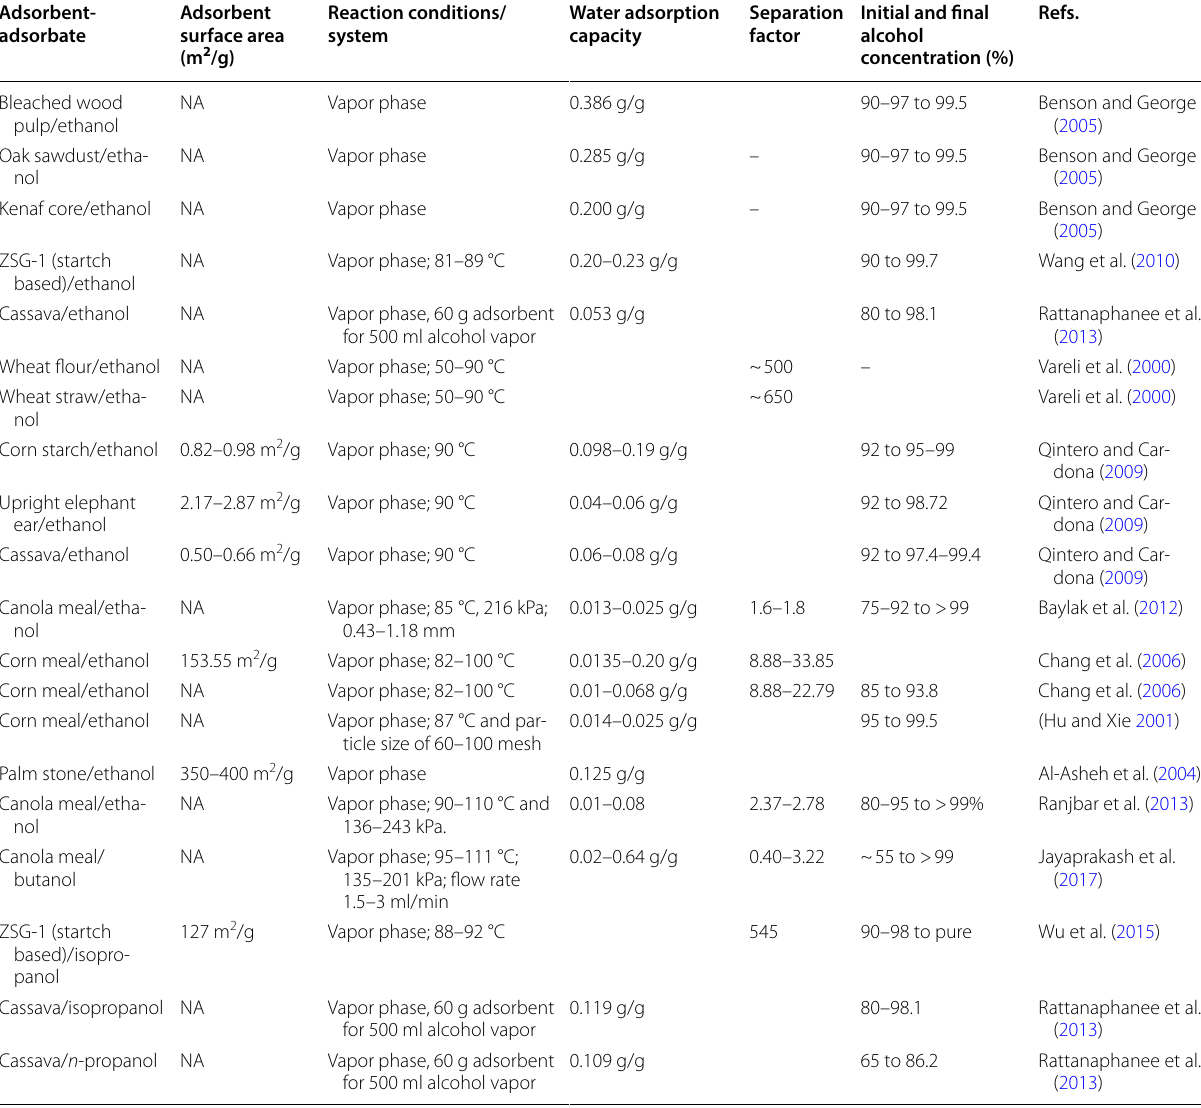
Table 6 Biobased sorbents for vapor phase drying of ethanol, butanol, and other alcohols Adsorbent-